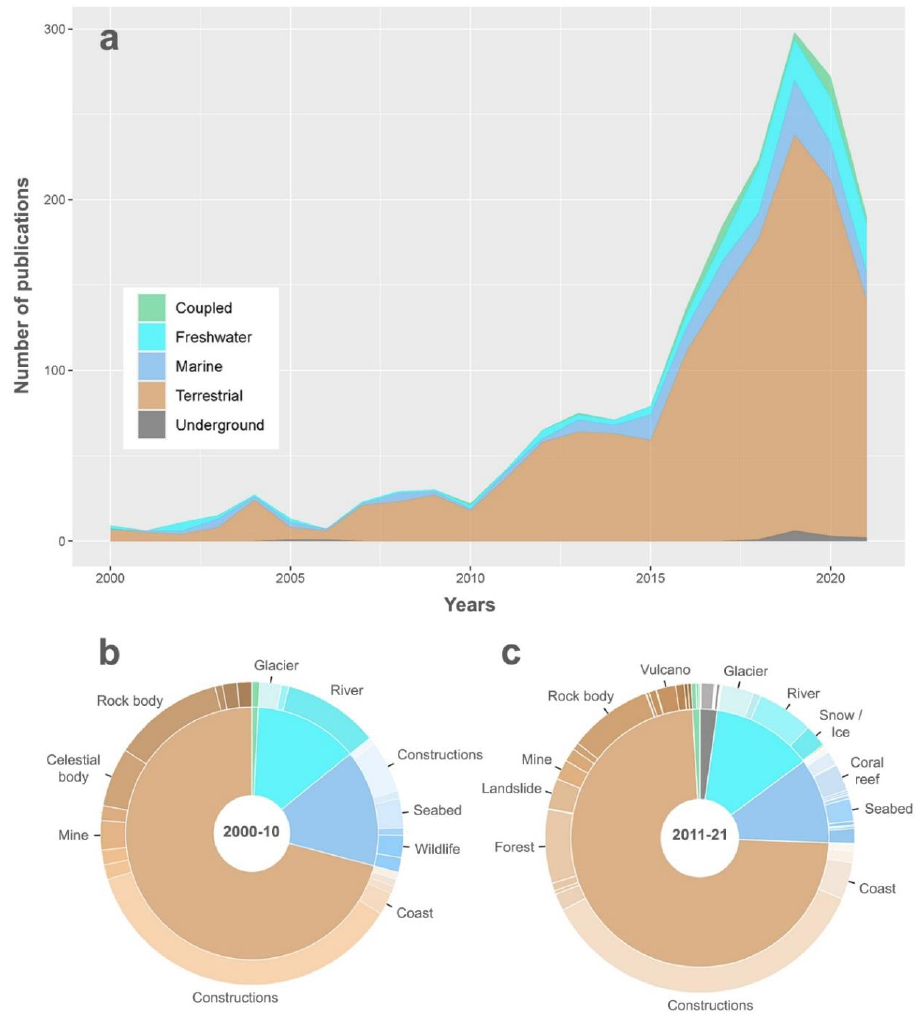
Figure 5. Type of environments addressed during the surveys over the past two decades: ( a ) temporal trend; ( b ) ring chart representing the percentage of surveys performed per environment from 2000 to 2010; ( c ) ring chart representing the percentage of surveys performed per environment from 2011 to 2021.